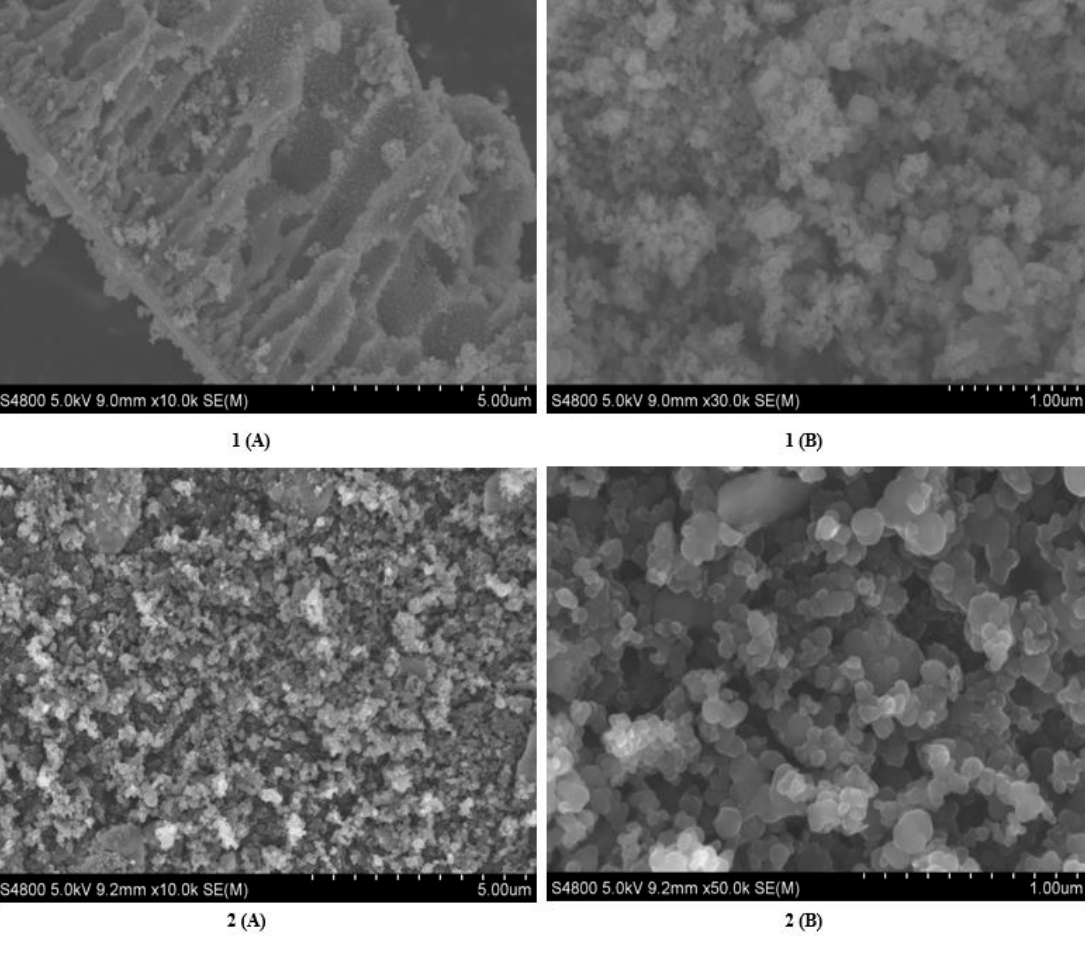
Figure 2. SEM 1 ( A ) low resolution image and 1 ( B ) high resolution image of TiO 2 nanoparticles, and SEM 2 ( A ) low resolution image, and 2 ( B ) high resolution image of N-doped TiO 2 nanoparticles.